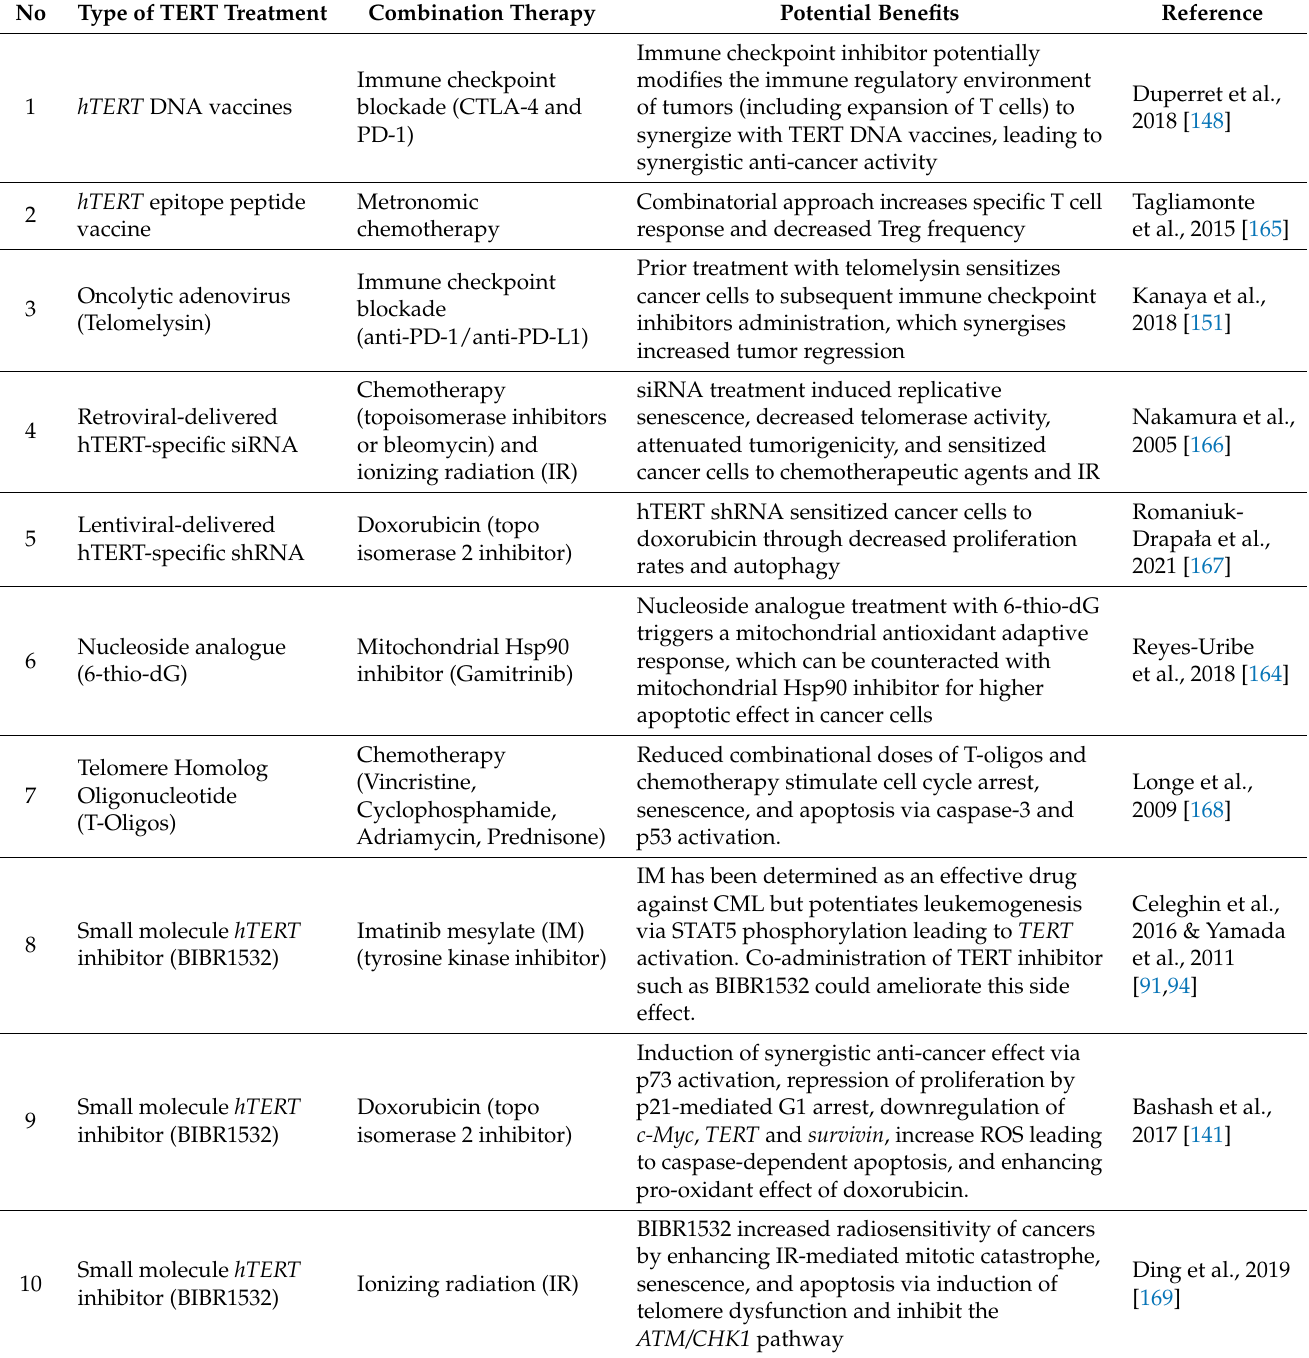
Table 1. Combinatorial effects of co-administering TERT targeted treatment with other anti-cancer agents. Potential benefits of the combined therapies indicate synergistic effects leading to tumor regression via multiple